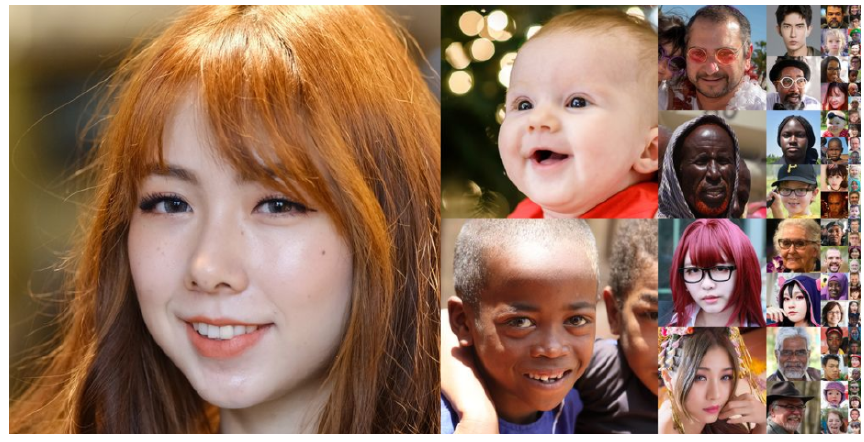
Figure 10. FFHQ Dataset